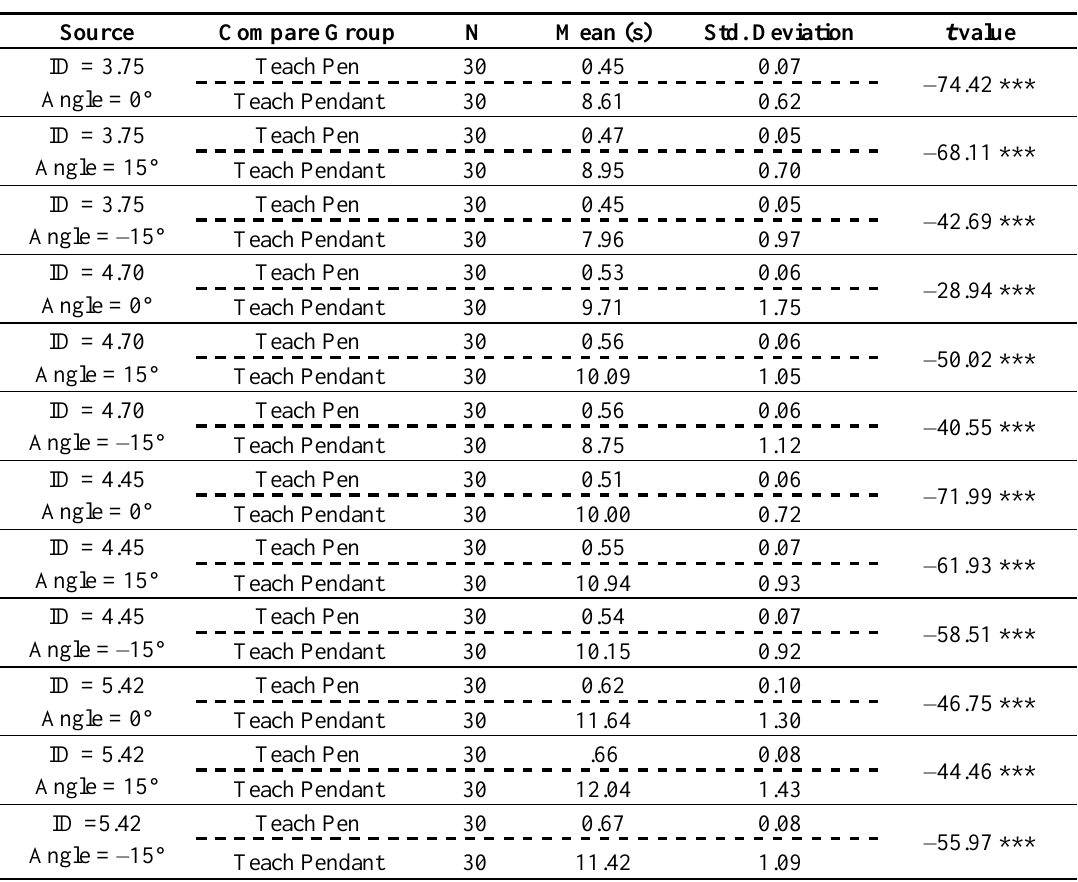
Table 4. Paired-samples t test table for the mean time operating the two tools at the same ID and inclination